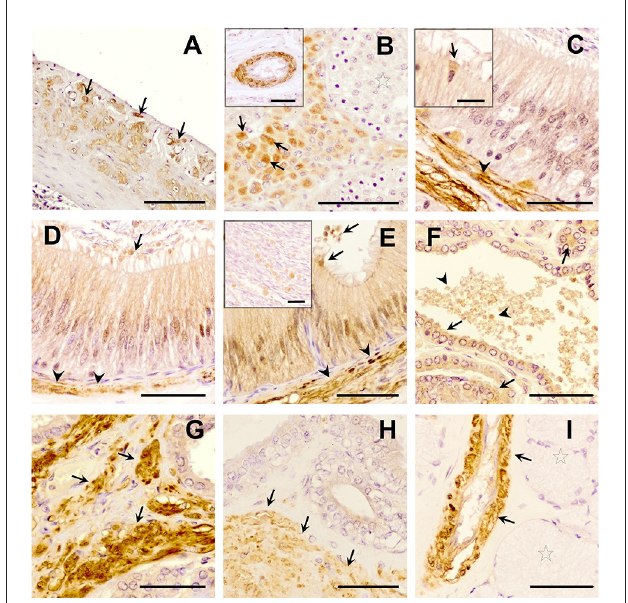
FIGURE4 Immunohistochemistry of Transforming Growth Factor (TGF)- β 3 in pig male reproductive tissues. Immunolabelling in (A) pig spleen (positive control), present in the trabeculae and capsule; (B) testes, in the cytoplasm of Leydig cells (arrows) and in vascular smooth muscle (in detail); (C) caput, (D) corpus, and (E) cauda epididymis, in smooth muscle cells (arrowheads), in the cytoplasm of the clear cells [detail in section (C) , arrows], and a weak immunostaining in the cytoplasm of principal cells and in luminal vesicles (arrows); (F, G) prostate, in epithelial cells [arrows, section (F) ], in luminal vesicles [arrowhead, section (F) ] and in smooth muscle cells [arrows, section (G) ];